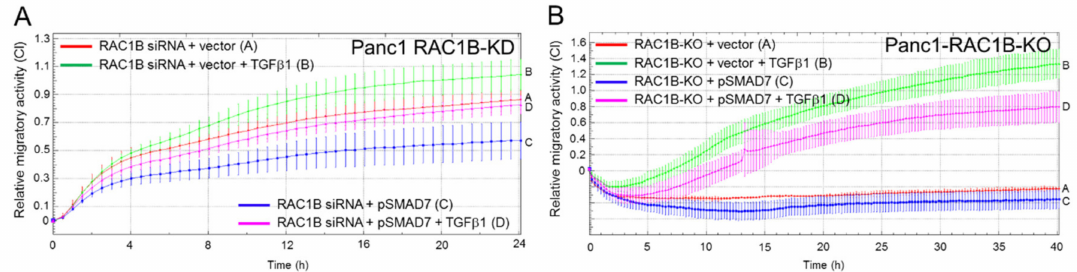
Figure 7. E ff ect of ectopic SMAD7 expression on TGF β 1-induced migration in Panc1-RAC1B-KD and KO cells. ( A ) Panc1-RAC1B-KD cells were generated by transfection with 50 nM of RAC1B siRNA on days 1 and 2, and on day 2, in addition, with either pSMAD7 or empty vector. Then, 48 h after the second round of transfection, cells were processed for migration assay. Data are the mean of 3–4 wells (the mean ± SD). Di ff erences between Panc1 + RAC1B siRNA + vector + TGF β 1 (green curve, tracing B) and Panc1 + RAC1B siRNA + pSMAD7 + TGF β 1 (magenta curve, tracing D) are significant at 04:00 and all later time points. Successful inhibition of RAC1B and ectopic over expression of SMAD7 was verified by immunoblotting. ( B ) Panc1-RAC1B-KO cells were transiently transfected with either empty vector or pSMAD7 and 48 h later subjected to migration assay. Immediately before the start of the assay one half of the cells in ( A , B ) received 5 ng / mL TGF β 1. Data in each panel are from one representative experiment and are the mean ± SD from 3–4 wells per condition. Di ff erences between Panc1-RAC1B-KO + vector + TGF β 1 (green curve, tracing B) and Panc1-RAC1B-KO + pSMAD7 + TGF β 1 (magenta curve, tracing D) are significant at 13:00 and all later time points. Successful inhibition of RAC1B and overexpression of SMAD7 was verified by